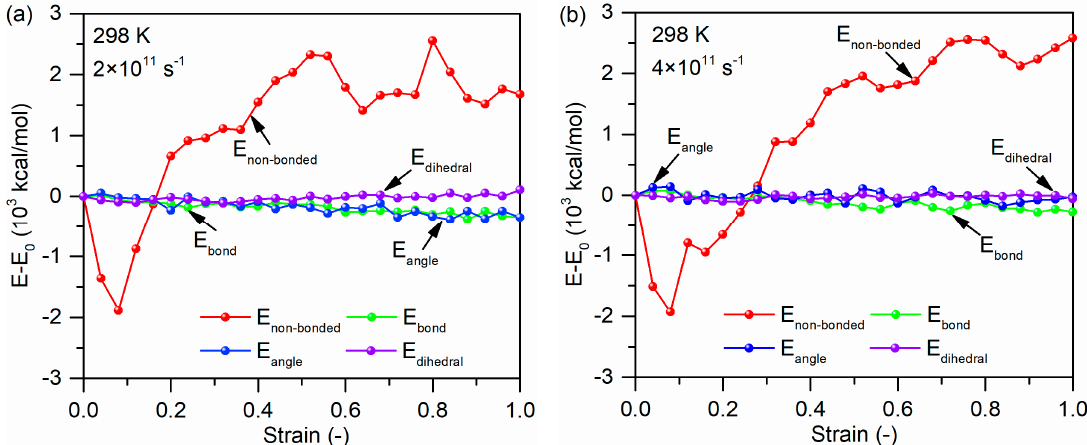
Figure 17. Potential energy decompositions of tensile process for the glass fiber / PP material system under the strain rate of ( a ) 2 × 10 11 s − 1 and ( b ) 4 × 10 11 s − 1 .